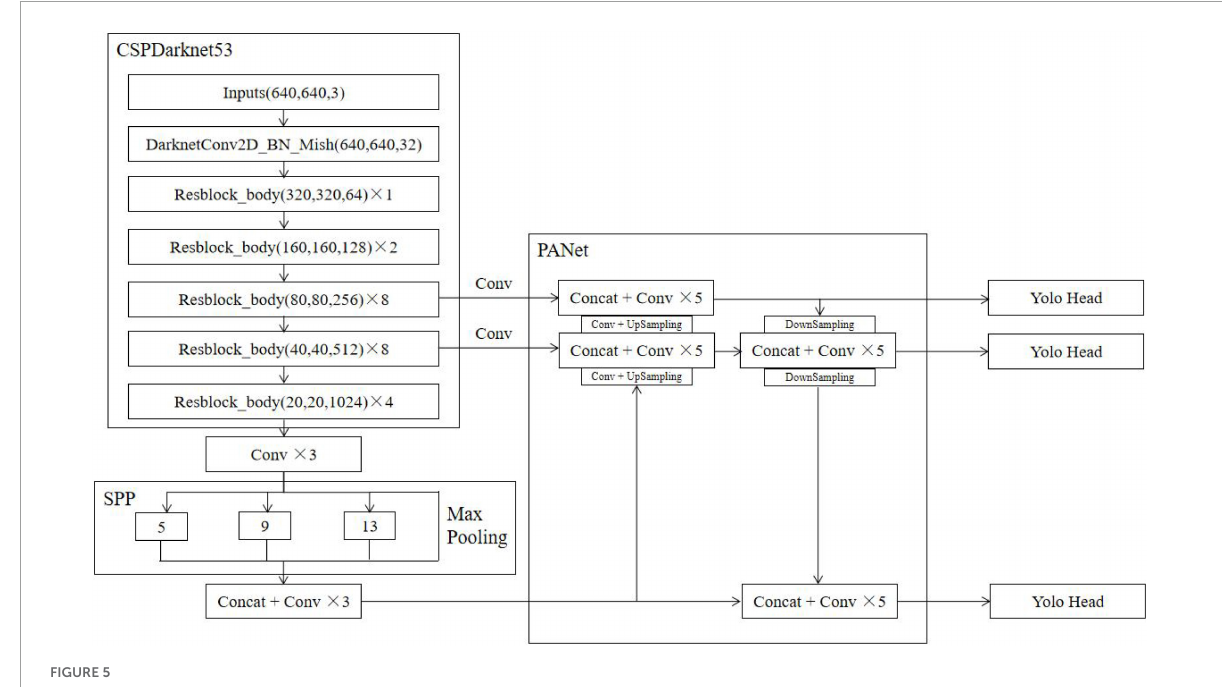
FIGURE5 Network model structure diagram of